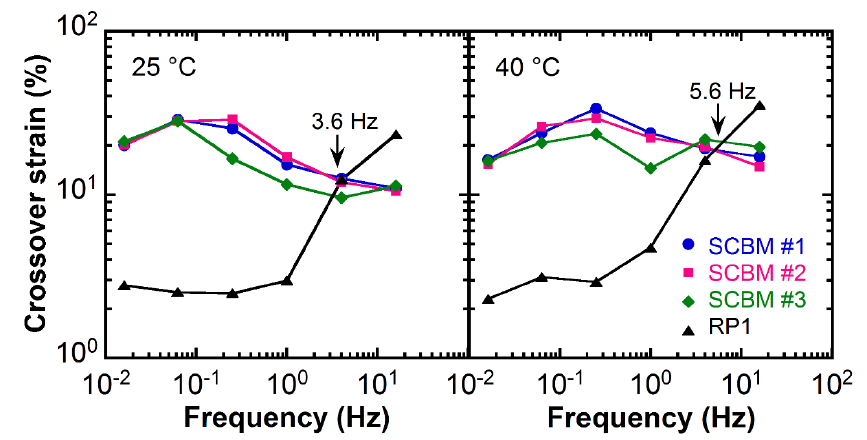
Figure 3. The crossover strains of G ’ and G ” from amplitude sweep measurements at 25 ◦ C ( left panel ) and 40 ◦ C ( right panel ) as a function of frequency. View in color for best